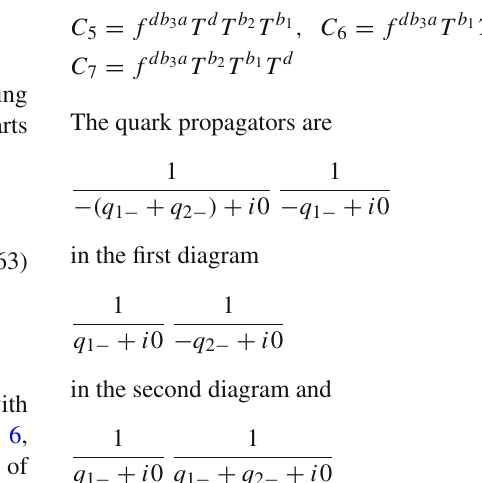
Fig. 5 Diagrams with the double interactions of the projectile and the gluon emitted from the R → RP vertex